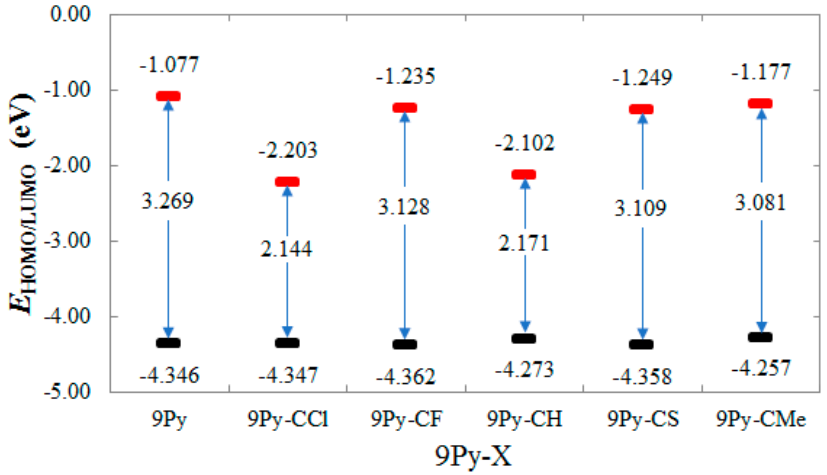
Figure 3. Frontier orbital energies: E HOMO (black marker), E LUMO (red marker), and E Gap (arrow) for the 9Py–HC complexes (HC = CCl, CF, CH, CS, and CMe). Table 6. Frontier orbital energies ( E HOMO , E LUMO , E Gap ), ionization potential, and electron affinity for the 9Py–HC complexes.